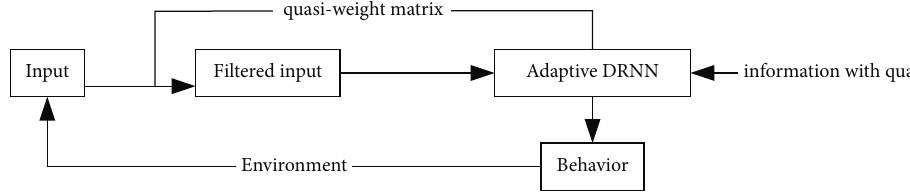
Figure 8: Adaptive weight